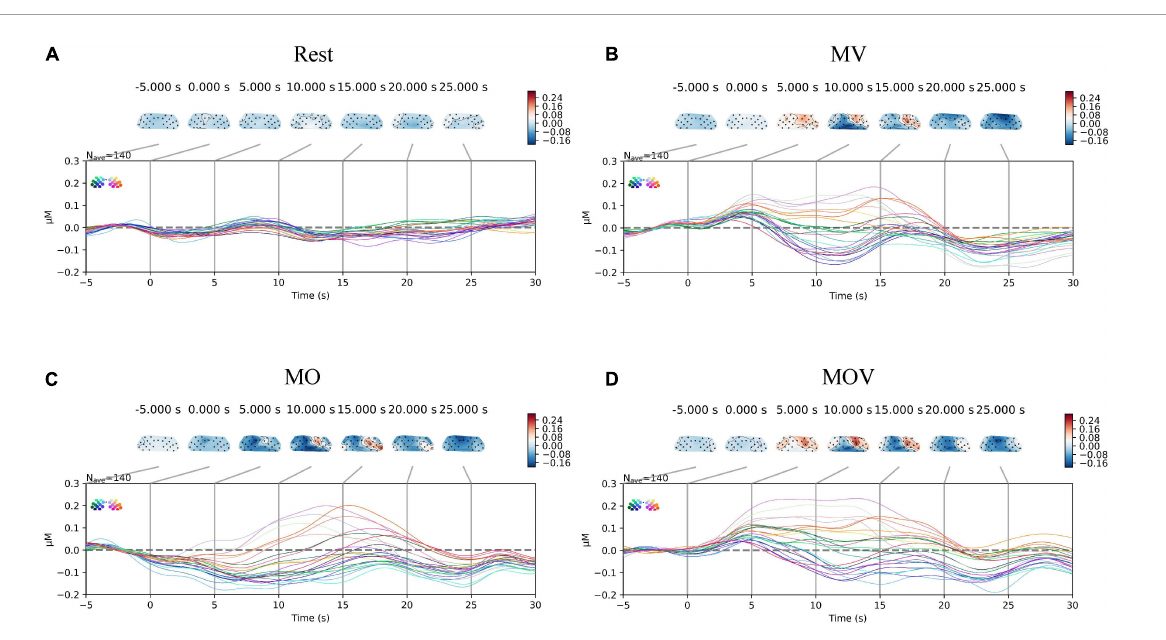
greater than that in the left-brain region. The MV task caused activation in the right hemisphere, with no more pronounced activation manifested in the left hemispheres Figure 6A